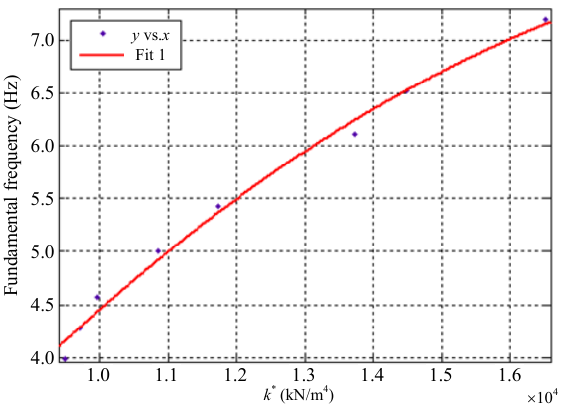
Fig. 10 k * values as a function of the fundamental